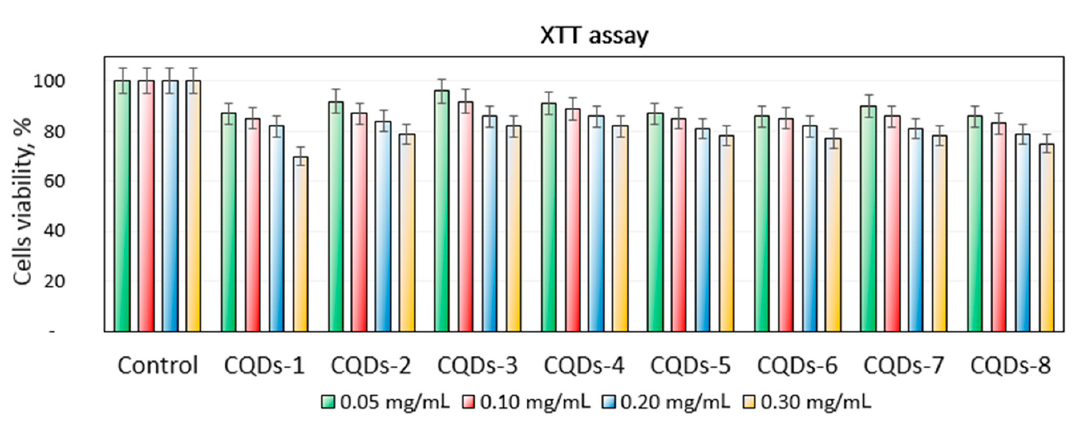
Figure 11. XTT assay carried out on mouse fibroblasts (L929 cell line).